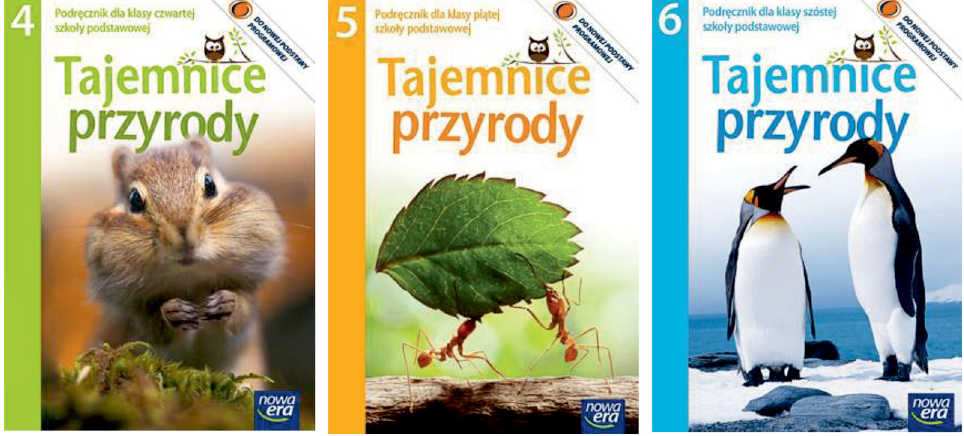
Fig. 5. Covers for a series of textbooks titled Tajemnice przyrody (The secrets of nature) (P4, P5,